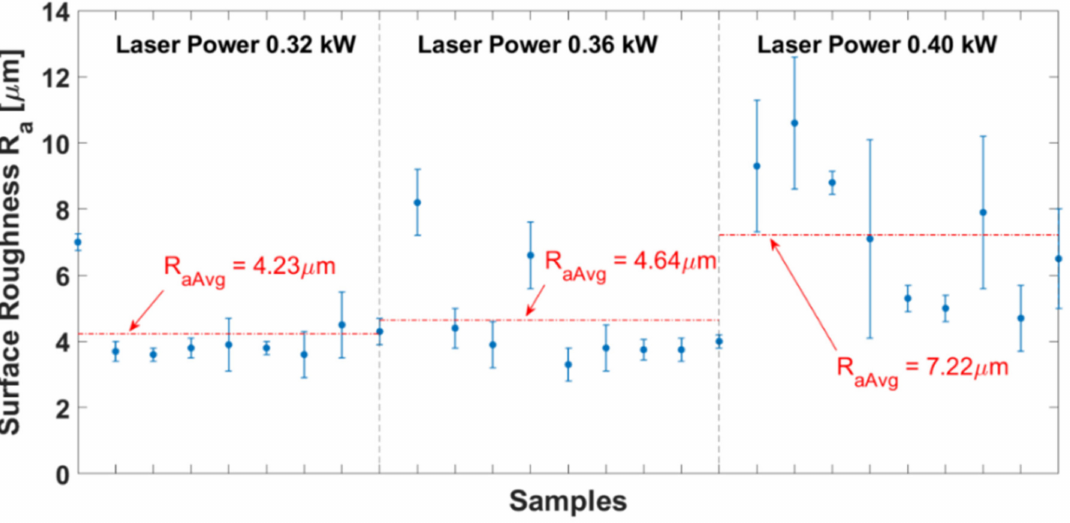
Figure 8. Surface roughness of three groups of samples printed by L-PBF with laser powers equal to 0.32, 0.36, and 0.4 kW (redrawn from ref.